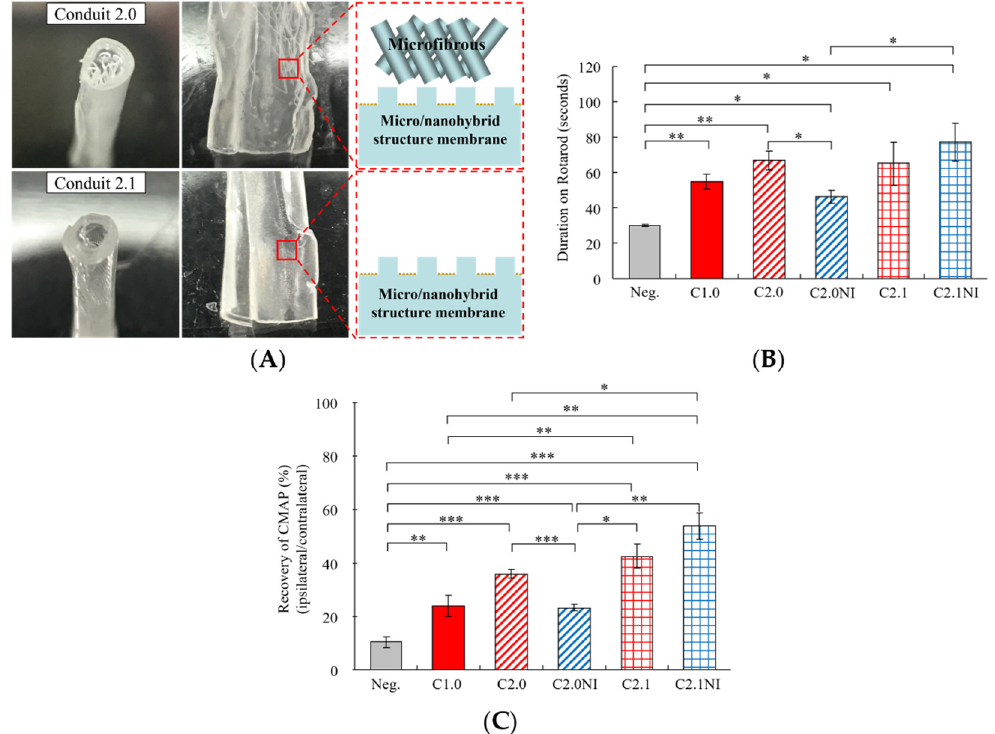
Figure 4. The construction design of PLGA conduits and functional assessments by using sciatic nerve injury FVB mouse model. ( A ) The microscopic views and illustration of structures in Conduit 2.0 and Conduit 2.1. ( B ) Quantitation of the Duration on Rotarod in the various treatment groups in the eighth week after surgery. ( C ) Quantitation of the Recovery of CMAP of the different treatment groups. The CMAP values of the injured and contralateral legs were measured in the eighth week after surgery. All data are presented as a mean ± SEM (n = 3 in Neg., C1.0, C2.0, C2.1, and C2.1NI groups, and n = 4 in C2.0NI group). Statistical differences are indicated by * p < 0.05, ** p < 0.01, and *** p < 0.001.